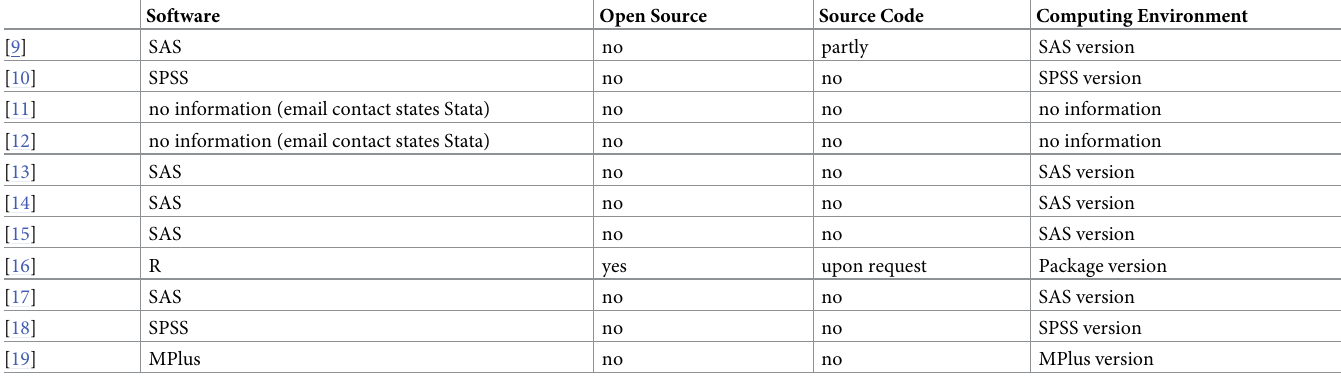
Table 3. Which software was used by the